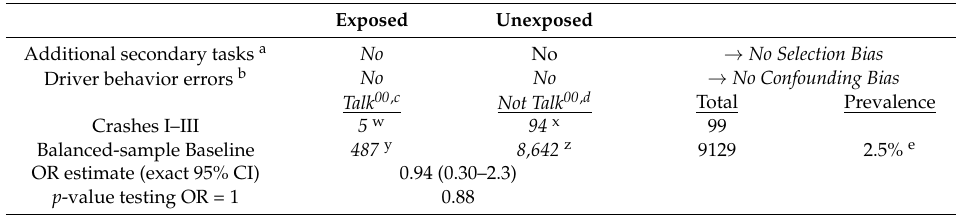
Table 5. Remove “driver behavior error” confounding bias from Table